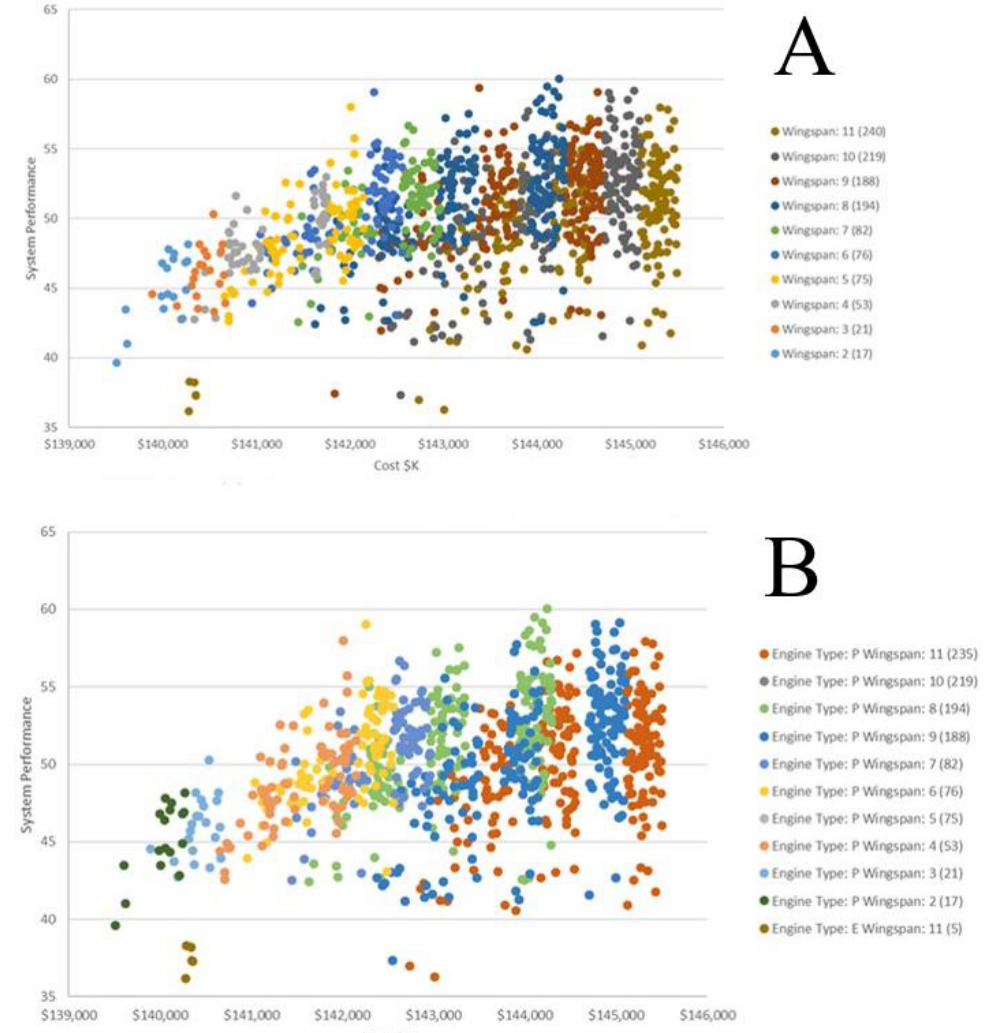
Figure 12. Tradespace Classified by ( A ) Wingspan (top) and ( B ) Engine Type and Wingspan (Bot- tom).